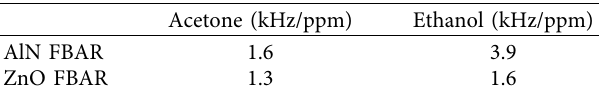
Figure 16: Te real-time frequency shift curves for acetone and ethanol detection. (a) Te real-time frequency shift for acetone detection. (b) Te real-time frequency shift for ethanol detection. Table 6: Te AlN FBAR sensitivity compared with ZnO